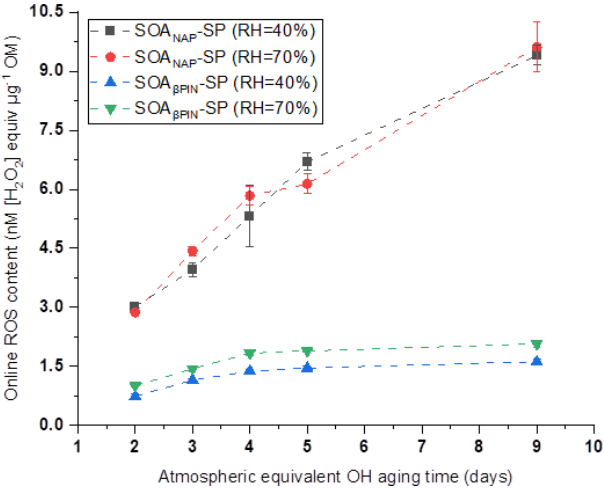
Figure 2. ROS content in anthropogenic SOA NAP -SP increased significantly with an increase in photochemical age from 2 to 9d. A significant but much slower increase was observed for the ROS con- tent in SOA β PIN -SP when aged for 2 to 4d. However, no significant increase in the ROS content in SOA β PIN -SP was seen for further ag- ing of 5 and 9d. A change in relative humidity (RH) from 40% to 70% showed marginal effects on ROS content in both aerosol types. Measurements were performed with the online instrument OPROSI. ROS was also quantified in uncoated soot (fresh and aged), but no ROS content was measured in uncoated soot; see text for